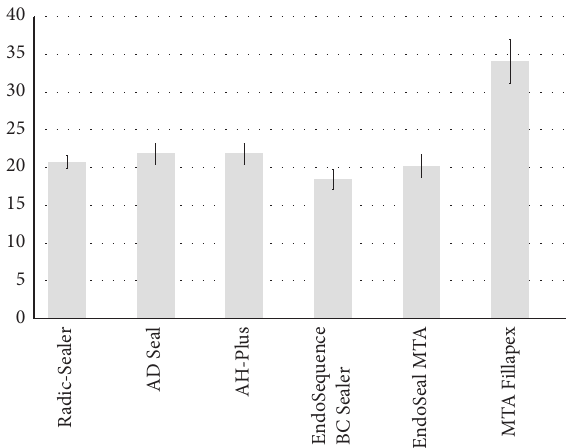
Figure 2: Flow values from each sealer evaluated (in mm). a , b , c Different letters present significant difference between groups ( 𝑃 < 0.05 ).